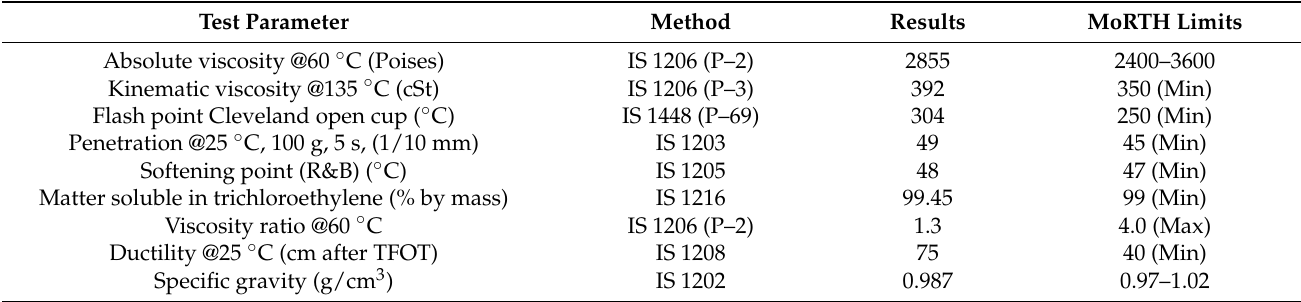
Table 2. Bitumen properties.